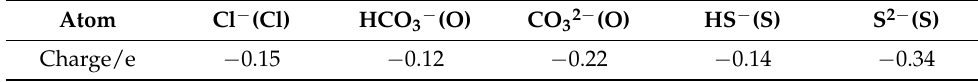
Table 3. Charge numbers of Cl, O, and S atoms in corrosive ions.